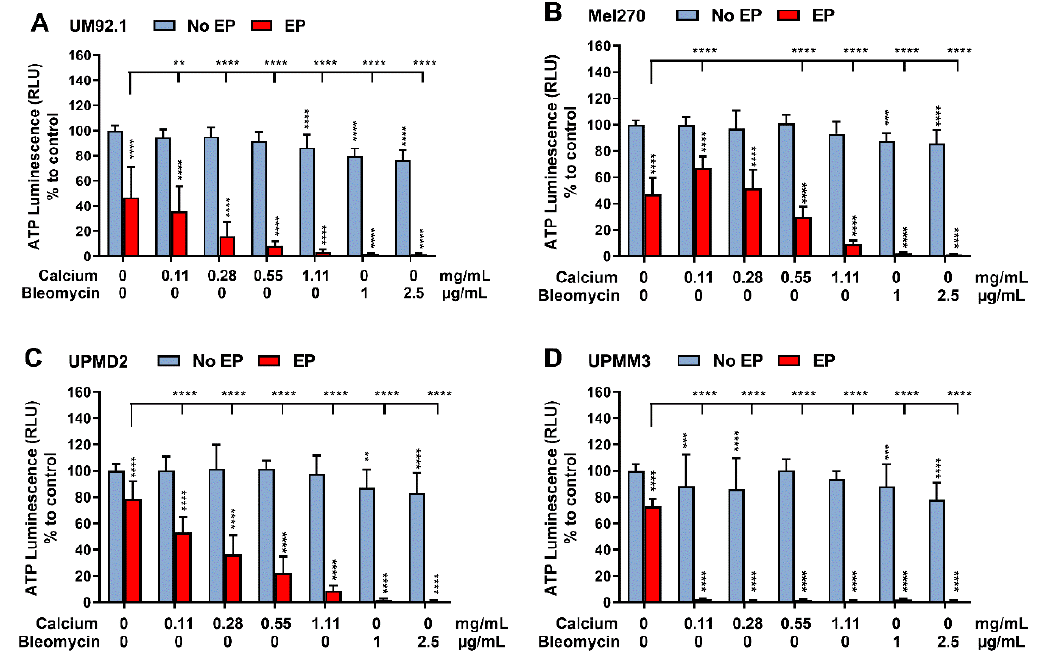
Figure 1. Intracellular ATP level in 2D UM cell cultures after CaEP and ECT. ATP depletion after calcium electroporation (0.11, 0.28, 0.55 or 1.11 mg/mL) compared to ECT with bleomycin (1 or 2.5 μg/mL ) on ( A ) UM92.1, ( B ) Mel270, ( C ) UPMD2, and ( D ) UPMM3 single-cell suspension (N = 3 or 4; n = 8 each condition) was assessed by lysing the cells and measuring the ATP luminescence (Relative Light Units; RLU) 24 h after treatment. The analyses show the non-electroporated (no EP) and centrations. The EP was conducted with 1000 V/cm pulse strength, 100 µs pulse duration, and 5 Hz repetition frequency. Untreated cells, calcium chloride alone, bleomycin alone (no EP group), or EP alone constitute the control groups. Statistical analysis was performed using a two-way ANOVA